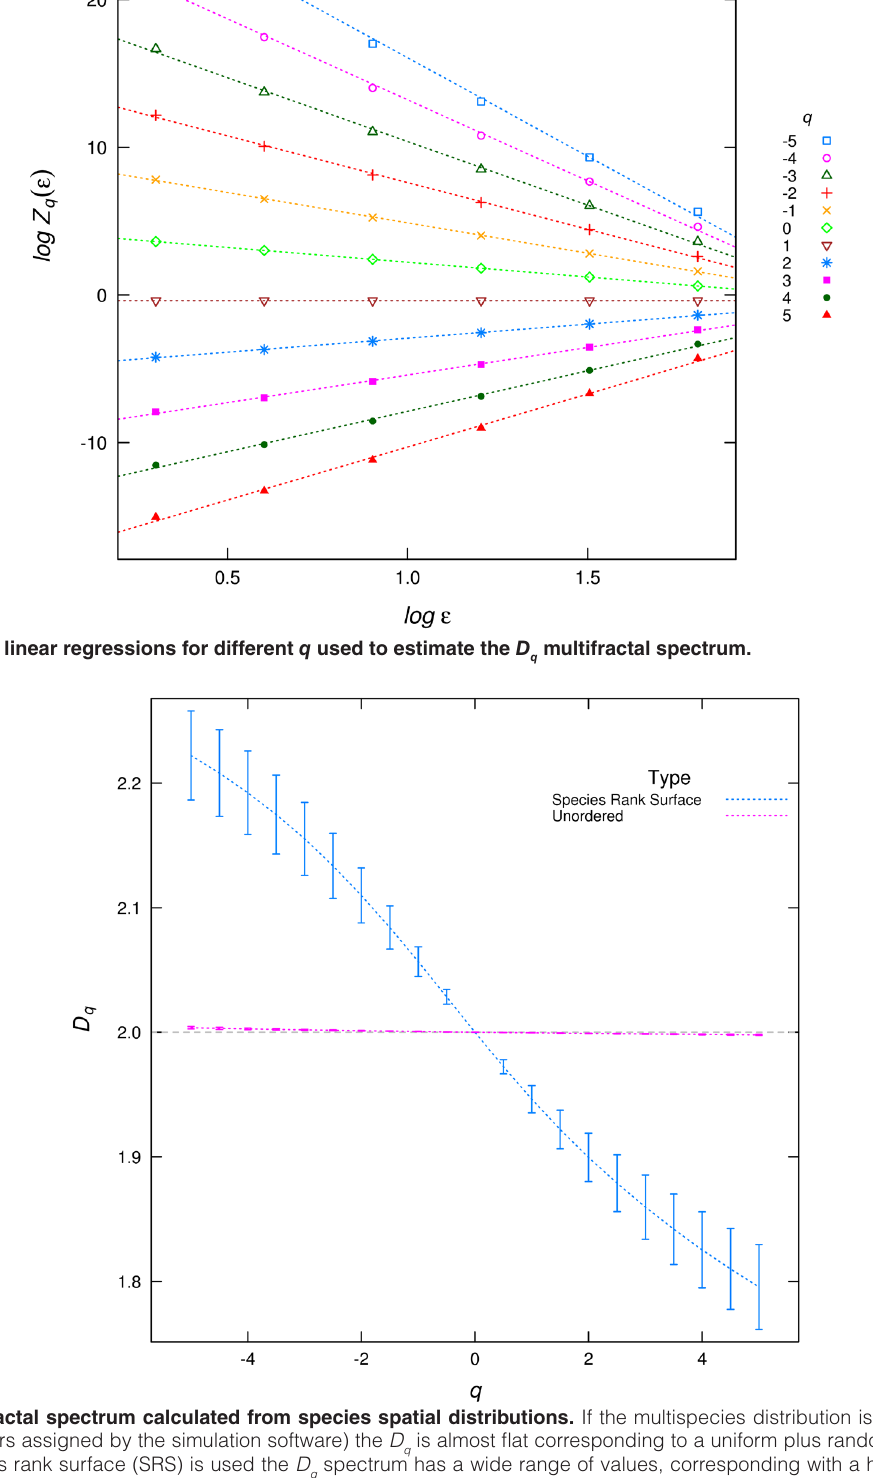
Figure 2. D multifractal spectrum calculated from species spatial distributions. If the multispecies distribution is analyzed unordered q (with species numbers assigned by the simulation software) the D is almost flat corresponding to a uniform plus random noise distribution. q But when the species rank surface (SRS) is used the D spectrum has a wide range of values, corresponding with a highly heterogeneous q distribution, formed of valleys for the most abundant species and peaks for rare species. The error bars are the standard deviation obtained from the linear regressions used to estimate D q